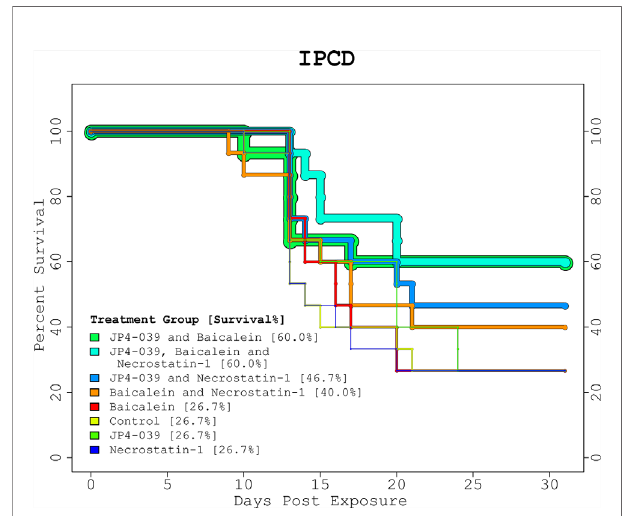
FIGURE 1 | GSAA Experiment Kaplan-Meier Plot. The KM plot for the 2 drug GSAA experiment demonstrates the survival rate of the 4 treatment combinations. Day 0 and 1 are baseline and post-irradiation, respectively. Note the fi rst necessary sacri fi ce occurs after day 9, and survivors past day 24 were assumed to have recovered from the TBI. Neither treatment nor control, guaranteed full survival or recovery. The treatment groups receiving G-CSF outperformed those with JP4-039 or control. The JP4-039 treatment was not statistically signi fi cantly different from the control with a p-value = 0.346.